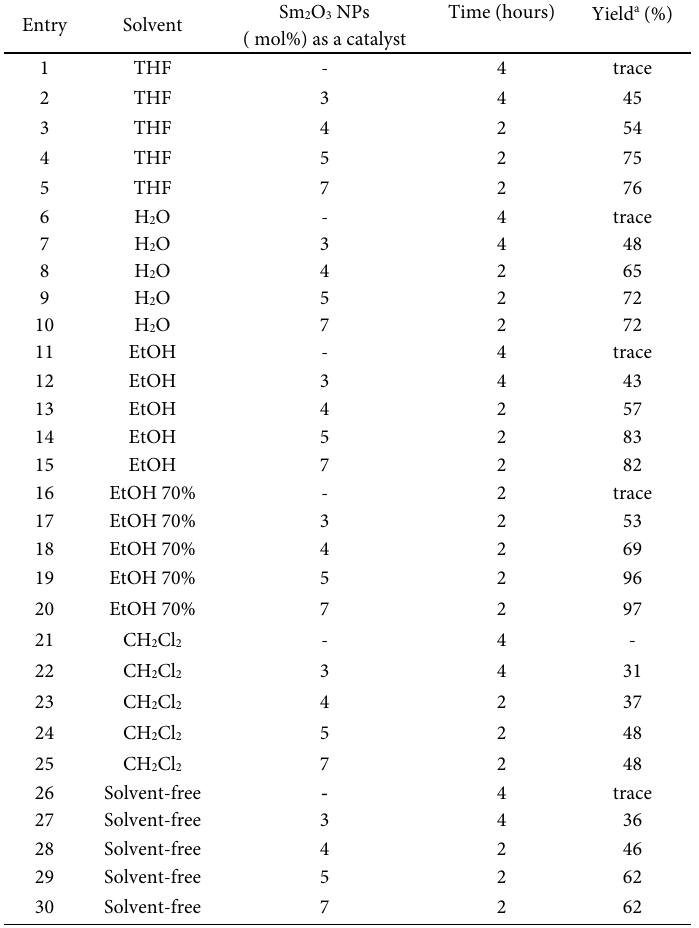
Table 2. The reaction of ortho phenylenediamine (1 mmol) and D-mannose (1 mmol) under different conditions